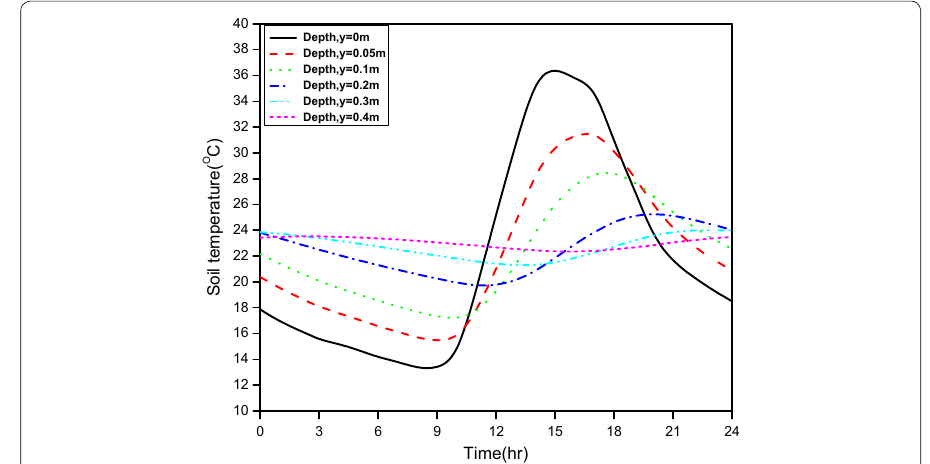
Fig. 9 Variation of soil temperature for the coldest day at various depths